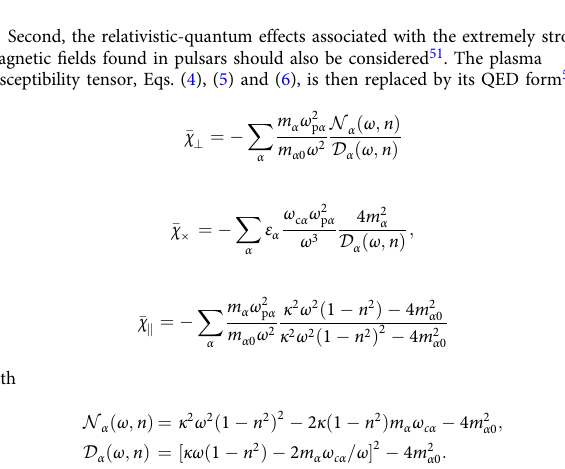
Fig. 4 Dependence of mechanical optical rotation on the magnetosphere model. Panel ( a ) depicts the polarisation rotation per unit length δ = Δ ϕ / l (in solid blue) obtained for different e – p magnetosphere models, and panel ( b ) highlights the behaviour near the cut-off. While QED corrections (in dotted orange) and e – p density asymmetry (in dotted yellow) do affect polarisation rotation near the cut-off, all three cases are found to deviate from the ω − 2 scaling (in dashed teal) near the cut-off. The symmetrical case is the baseline computed for B 0 = 10 8 T, n = 7 ×10 20 m − 3 and P = 0.5 s. The non-symmetrical is computed for n p = n and n e = n (1 − f )/ f with f =